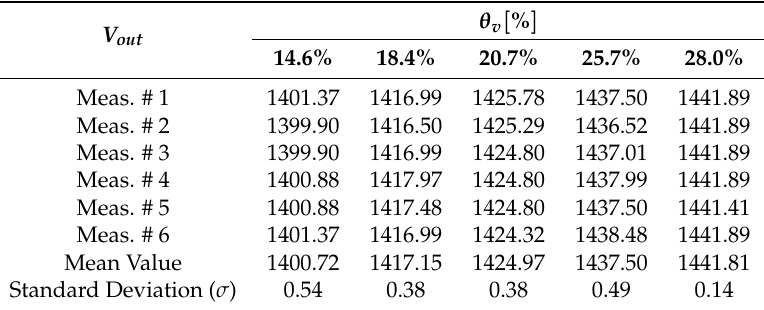
Table 1. Measured V out [mV] in the repeatability